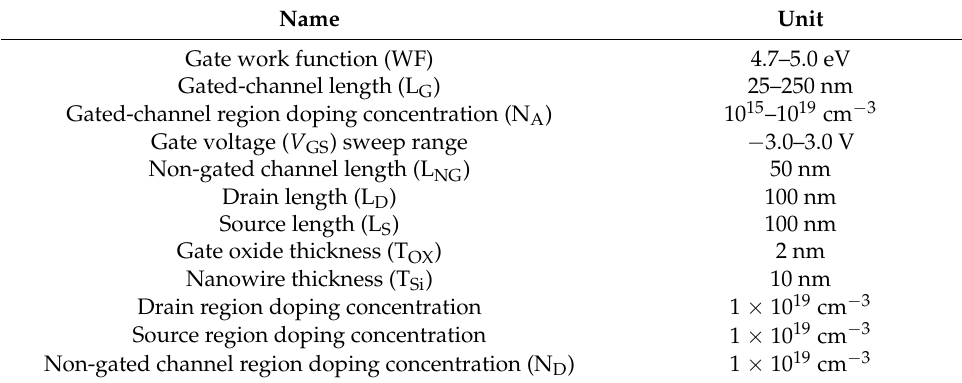
Figure 1. Silicon nanowire FBFET structure for the TCAD simulation: ( a ) three-dimensional structure and randomly varied parameters; ( b ) cross-sectional view of a silicon nanowire FBFET. Table 1. TCAD simulation parameters.